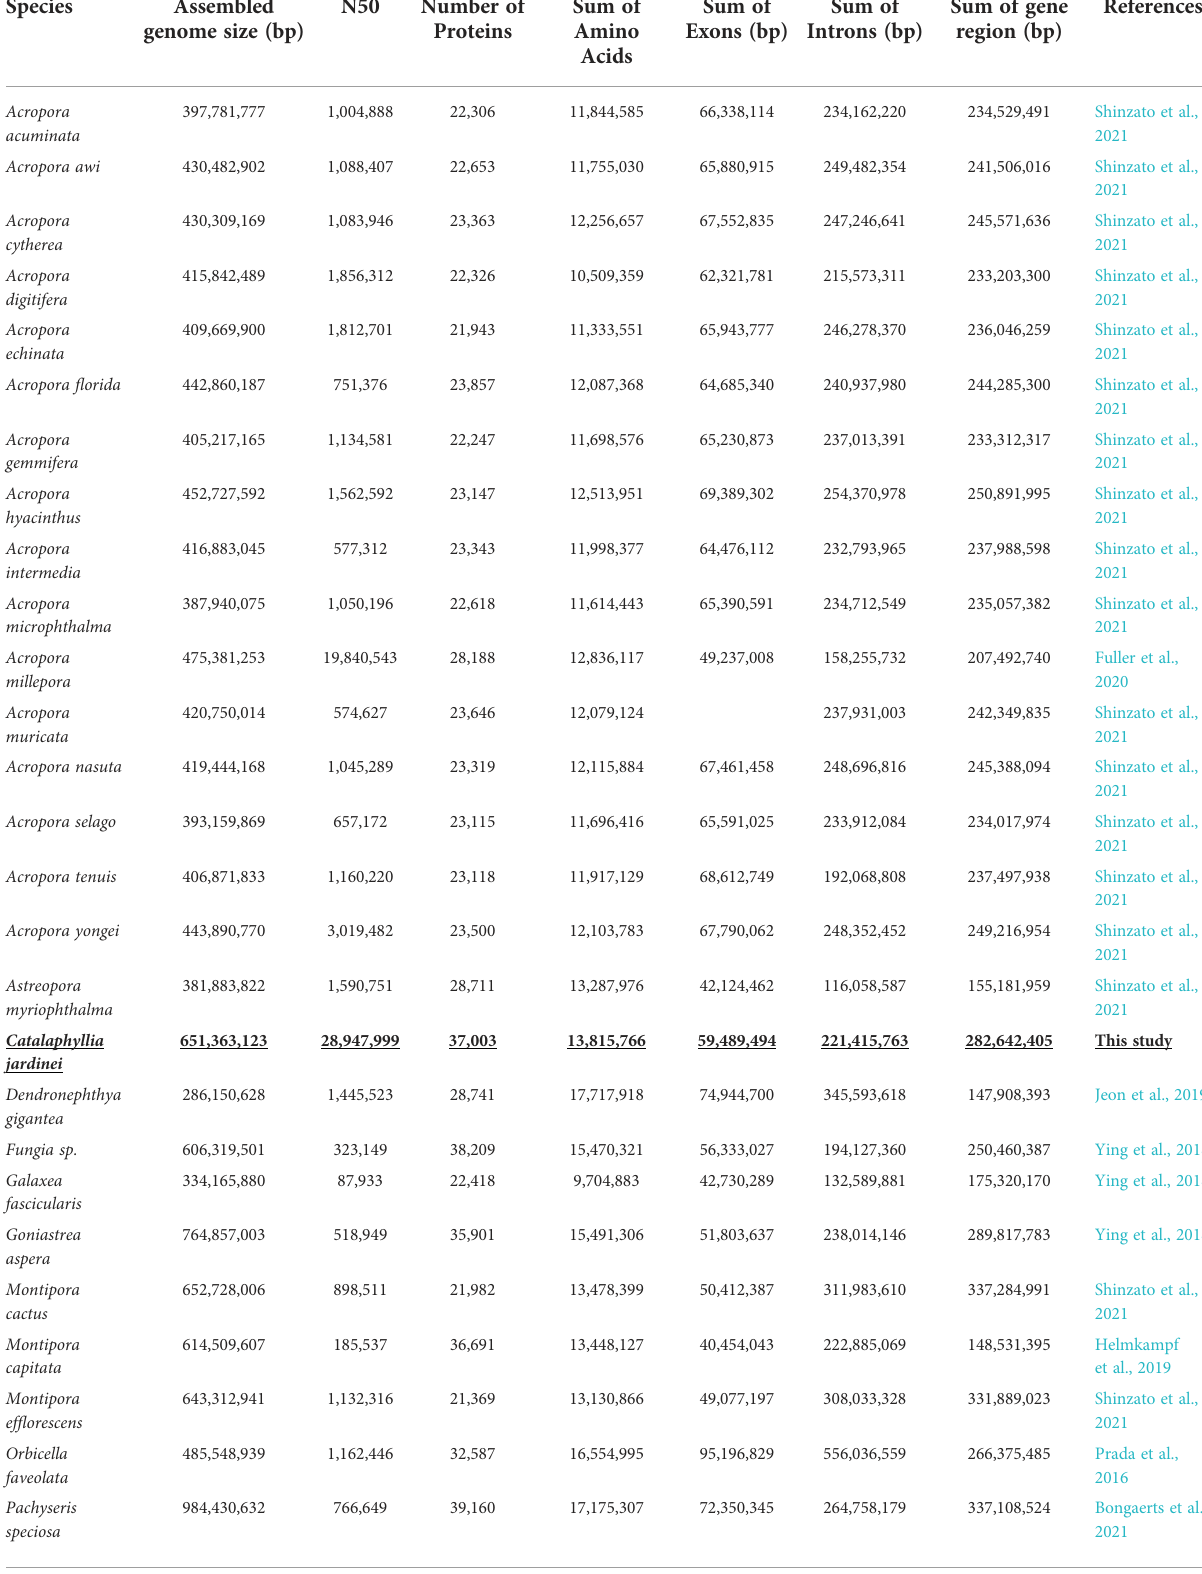
TABLE 1 Statistics of published coral genomes. Species Assembled